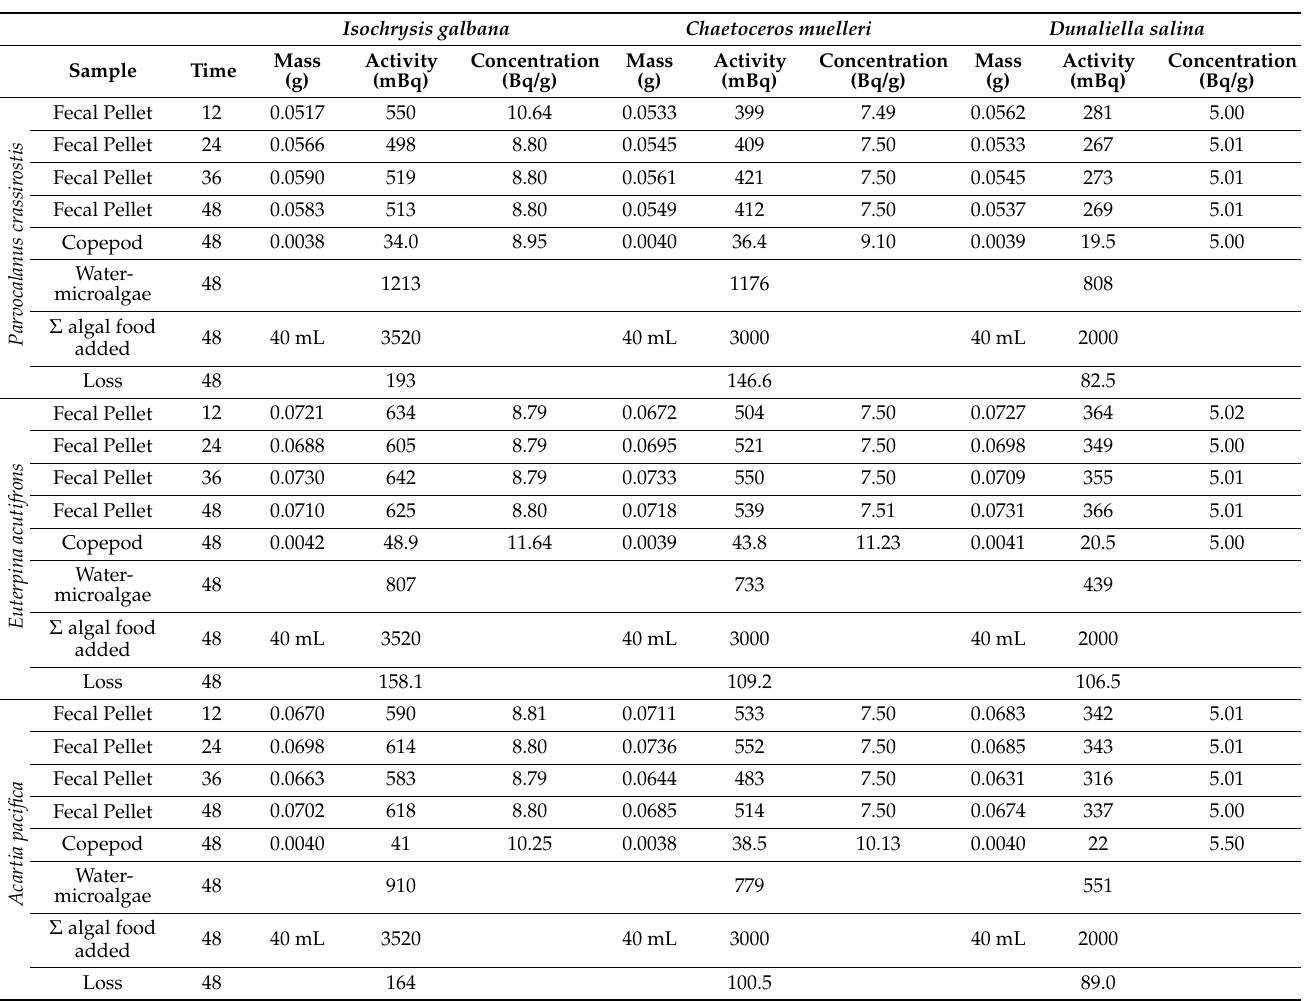
Table 3. 209 Po concentration in the experimental samples at 8.2